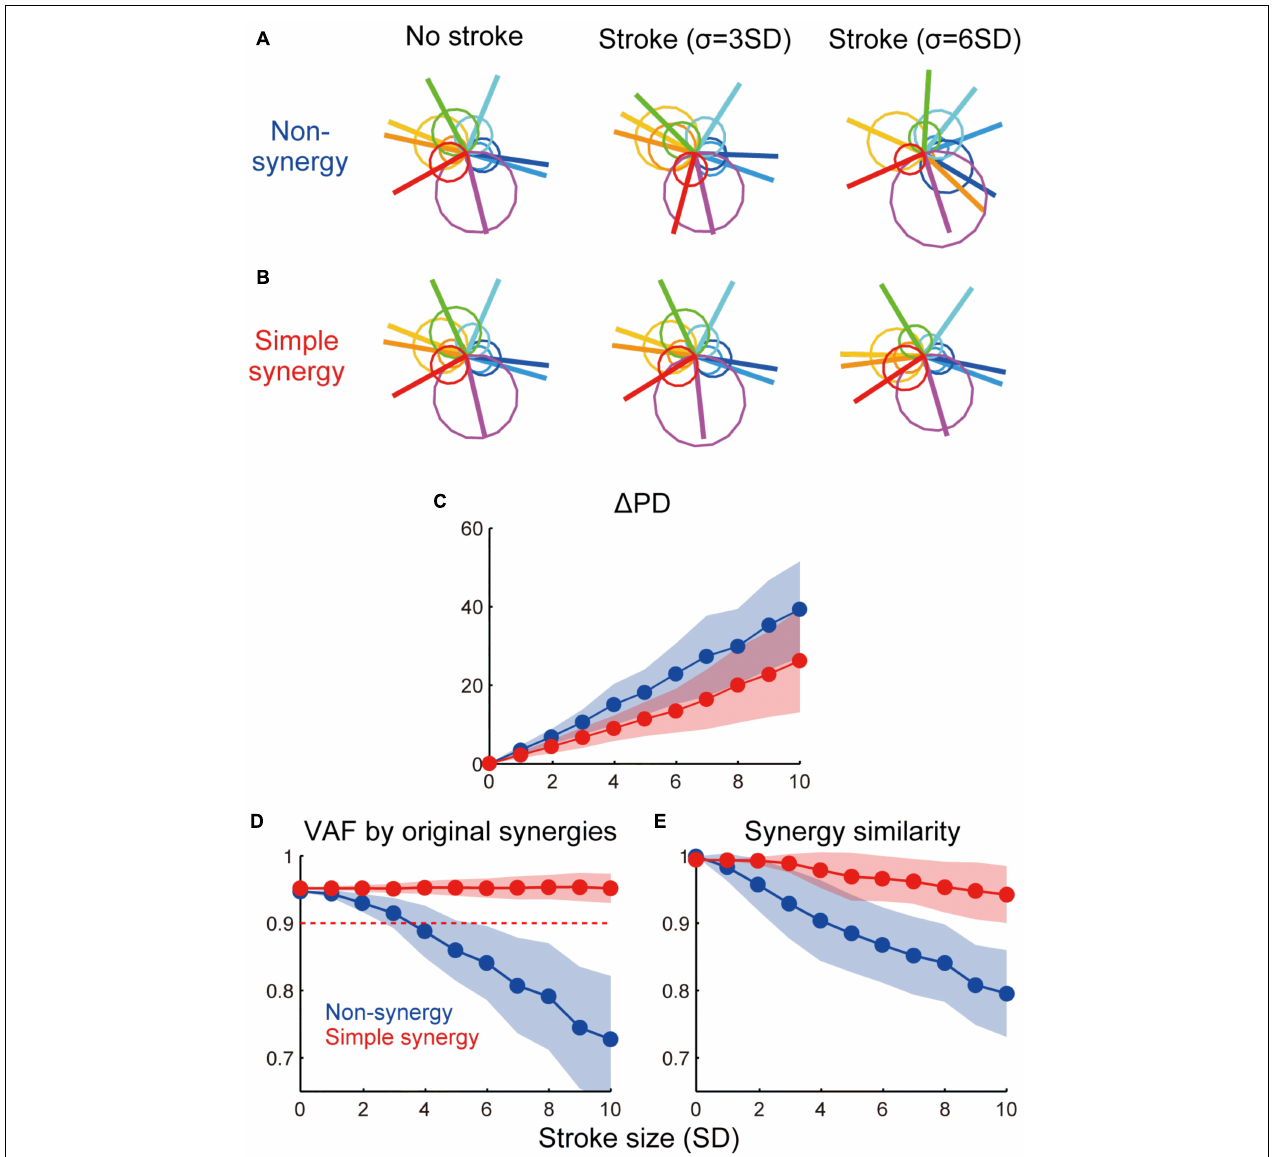
FIGURE 5 | Effect of cortical stroke on muscle synergies. (A,B) Examples of muscle activation with non-synergy model (A) and simple synergy model (B) in no-stroke and two different sizes of stroke cases ( σ = 3 and 6 SD). Circles indicate muscle activation for each torque direction and lines indicate a PD of muscles. (C) Averaged shift of PD ( (cid:49) PD) from no stroke ( σ = 0) condition. (D) VAF by original muscle synergies extracted from non-synergy model and used for simple synergy model (Figure 1F) . (E) Similarity of muscle synergies extracted in each stroke case to the original muscle synergies. The format is the same as Figures 4C,D